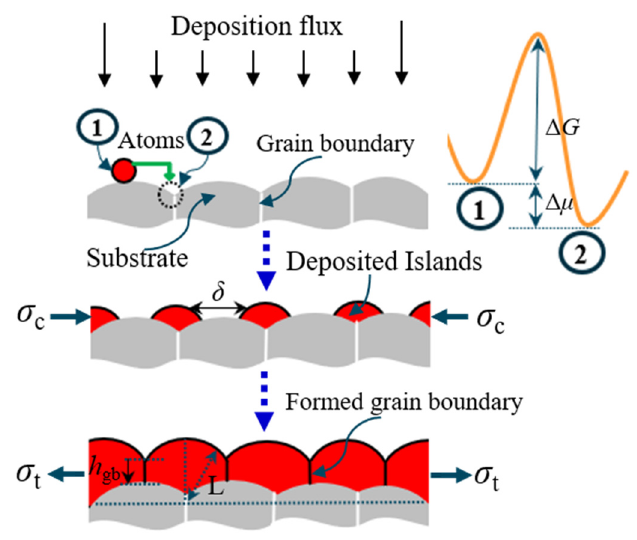
Figure 10. Formation mechanism of the residual stress during the deposition process.